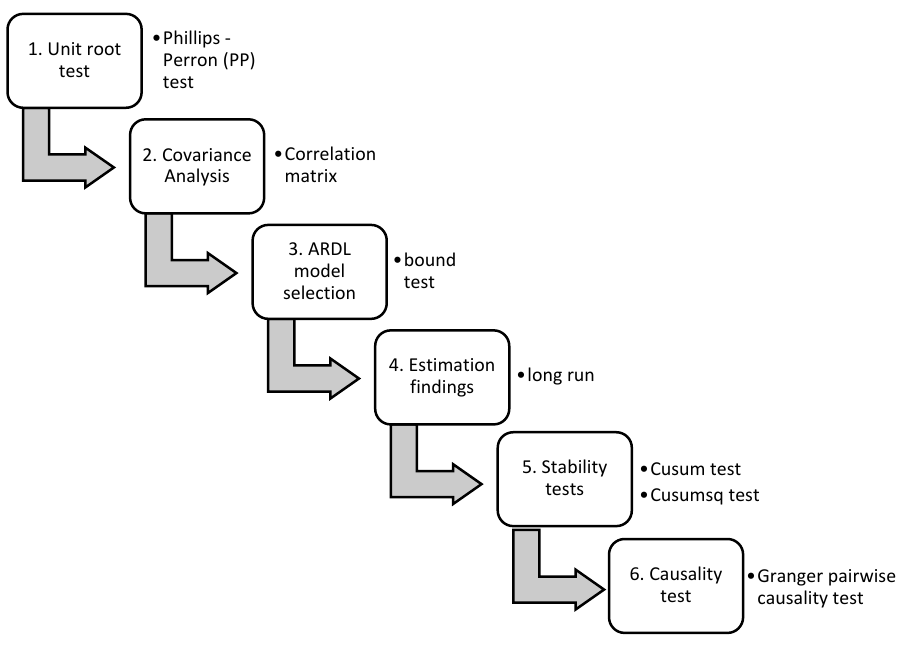
Figure 1. Stages of research methodology.